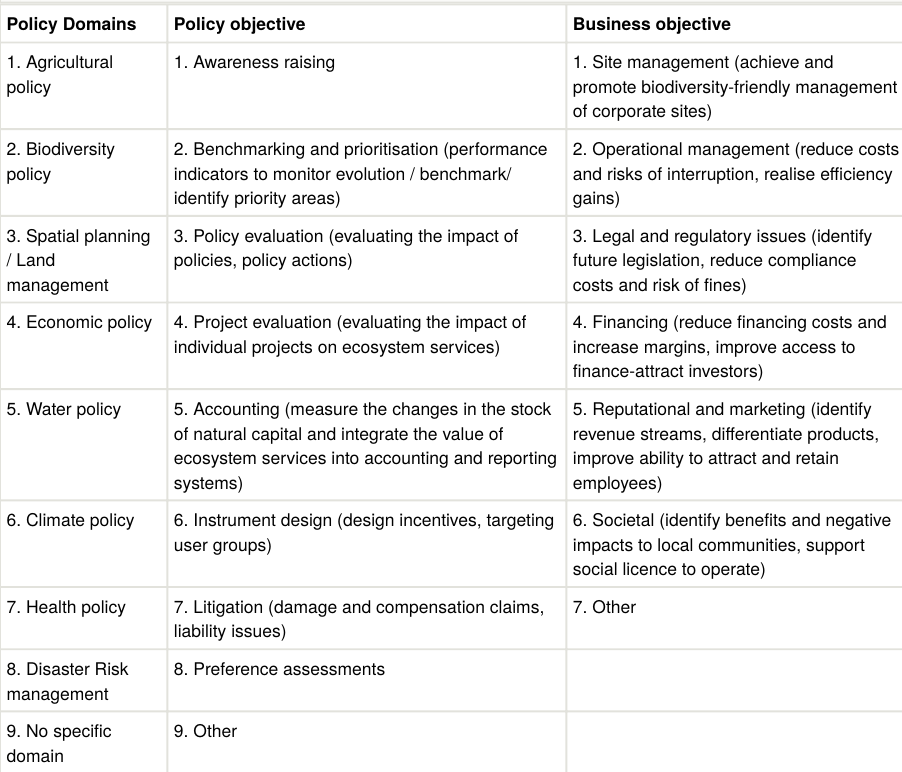
Table 2. Policy and business objectives described in the database linked with the mapping and assessment